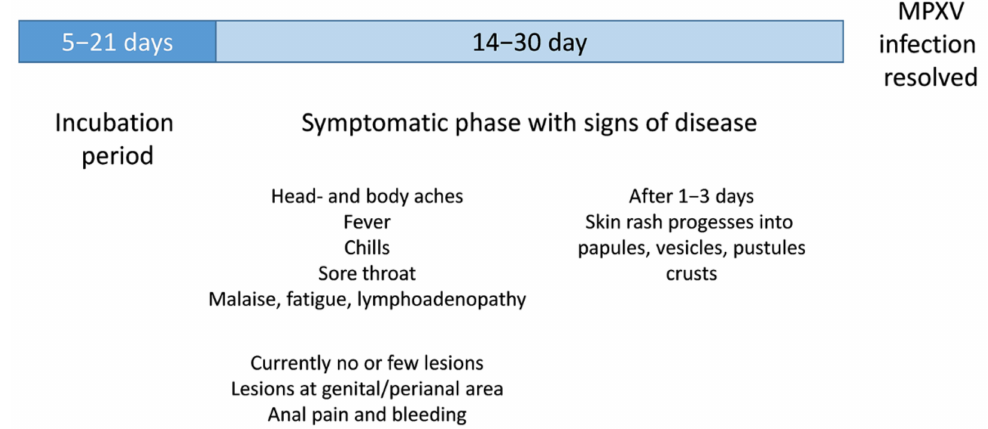
Figure 1. Schematic illustration of clinical signs of a MPXV